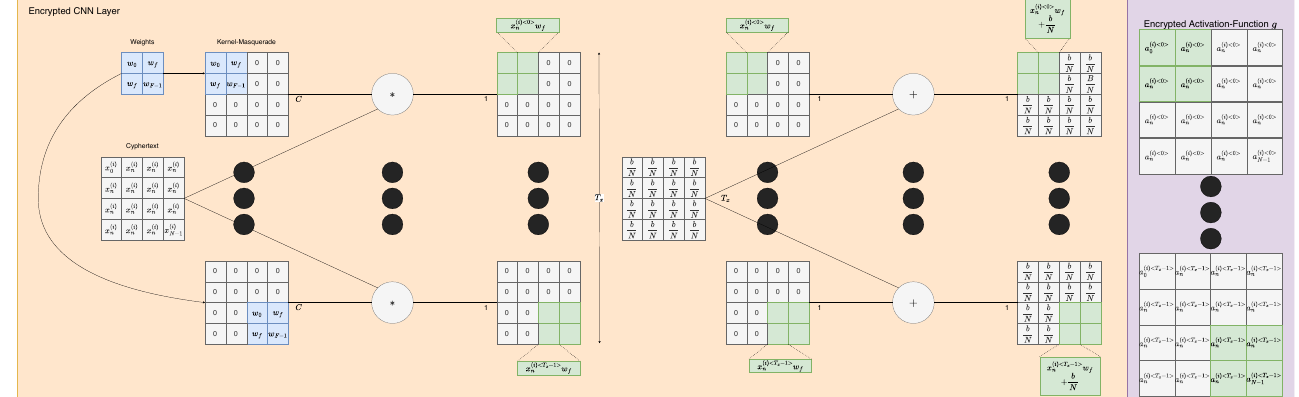
Figure 8. Encrypted convolutional neural network (CNN). This is a particularly unusual implementa- tion since there can be no summing of the filters. Instead, this sum is commuted in the case where the filter operates on an input that is a single cyphertext (i.e., not a composite of multiple cyphertexts). Please see our documentation for closer detail [28].